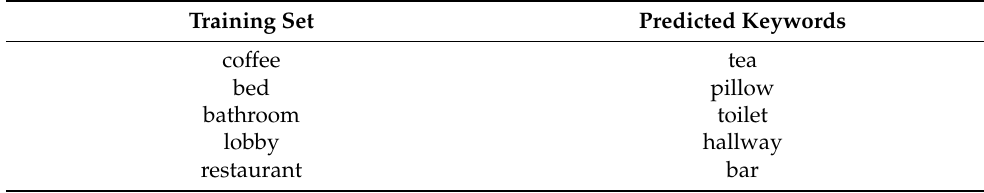
Table 2. Examples of keyword